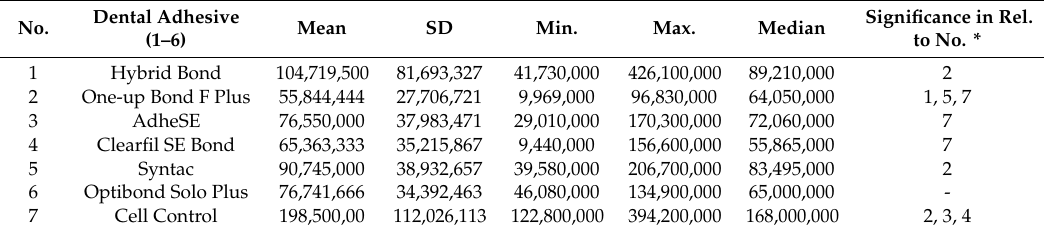
Table 3. Mean, Standard deviation (sd), minimum (min.), maximum (max.) and median values of the six dentin adhesives (viable cells).